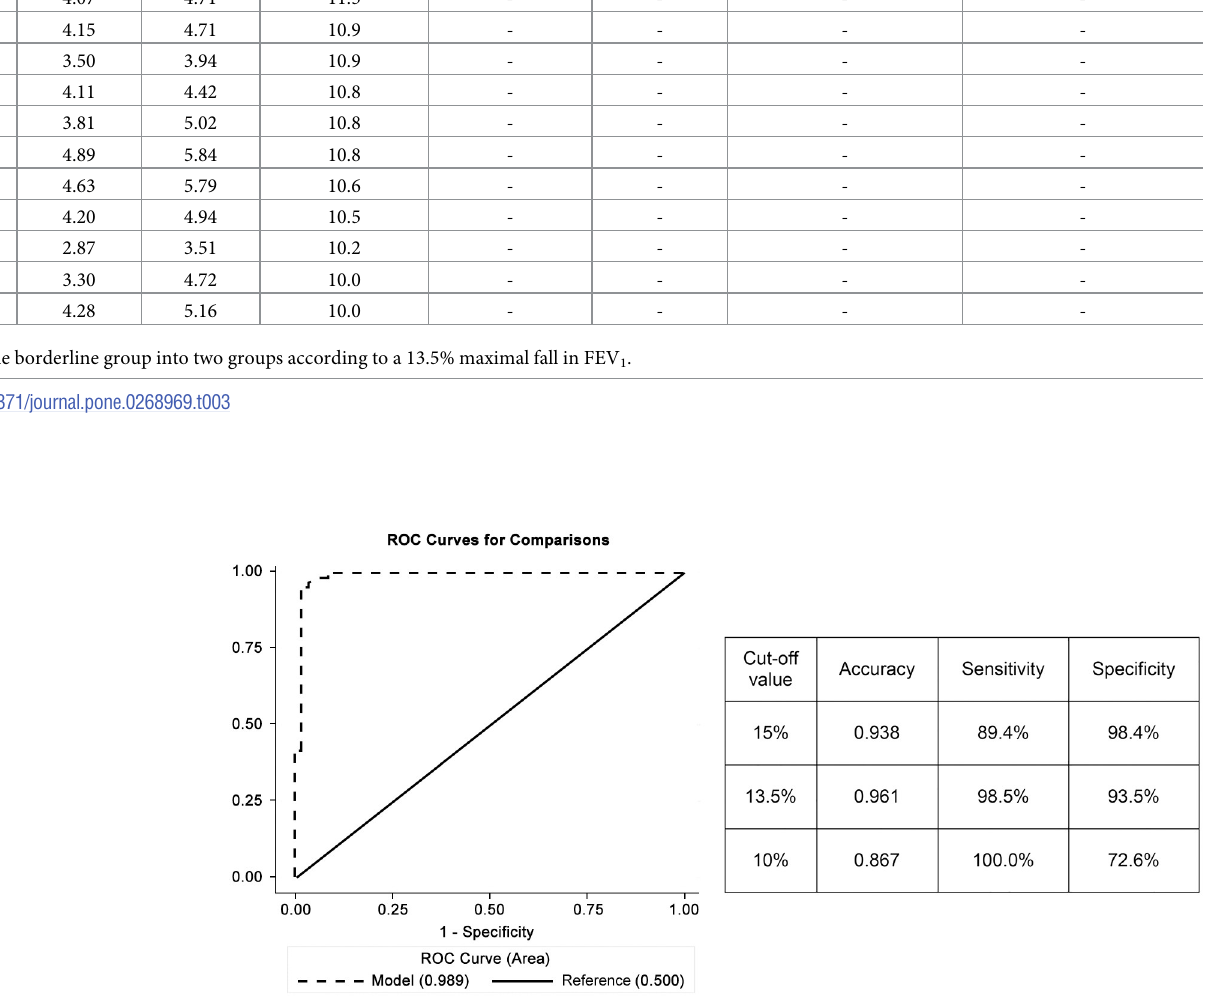
Fig 3. ROC curve, accuracy, sensitivity, and specificity of the cut-off